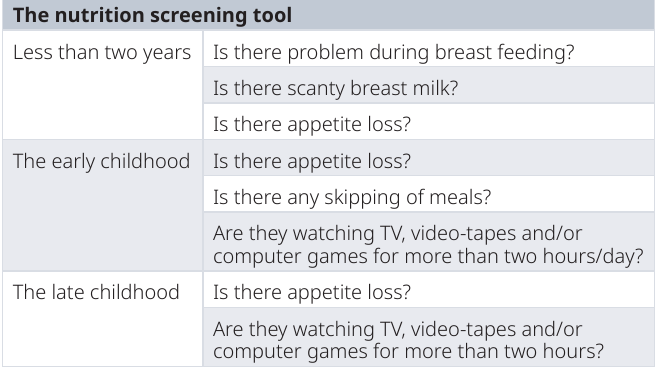
Table 11. The nutrition screening tool. The nutrition screening